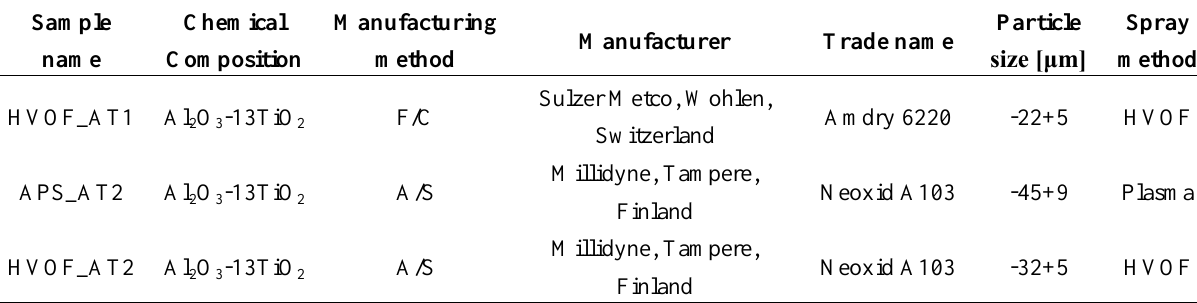
O -13TiO powder 2 3 2 O -13TiO powder (Amdry 6228, 2 3 2